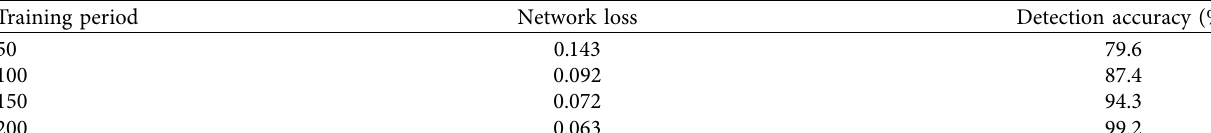
Table 1: The improvement of model performance as the training period grows.